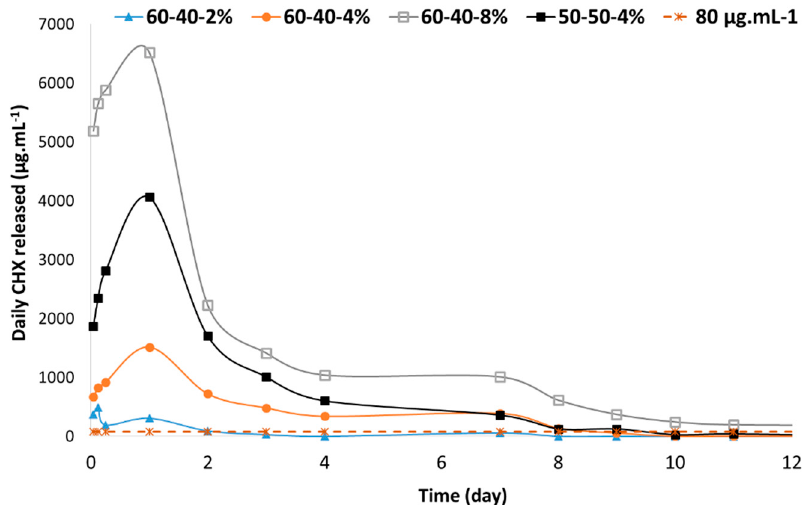
Figure 8. Daily CHX concentration, measured by UV spectrometry, released by a membrane (115 mm 3 ) according to the formulation (polymer ratio and CHX loading).